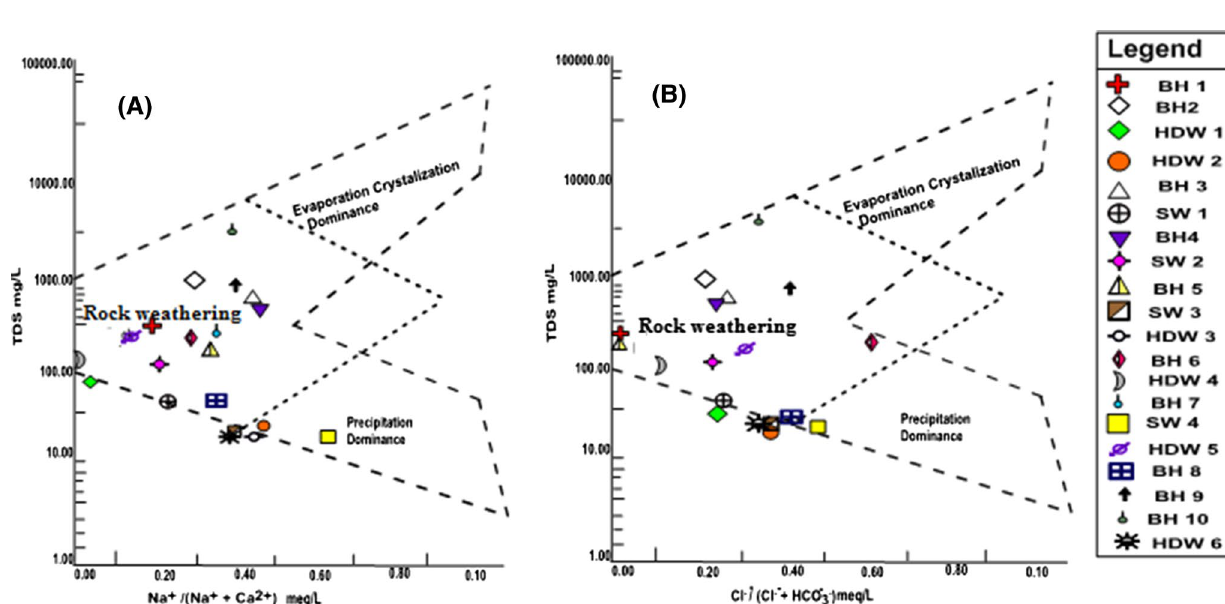
Fig. 8 Gibbs graphs showing (influence of precipitation on rock weathering as) the major primary geochemical